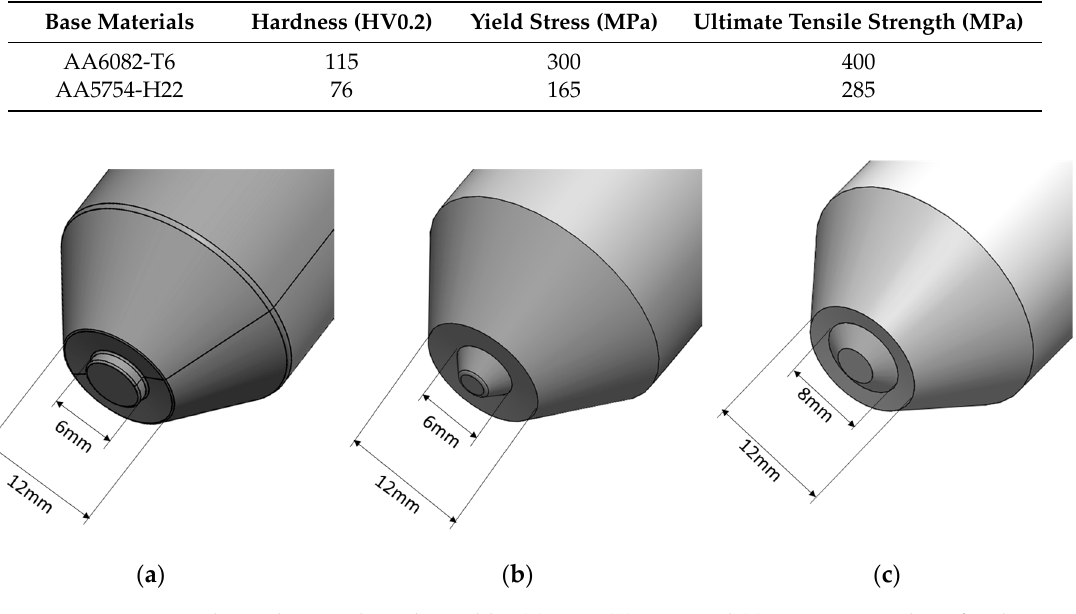
Figure 1. FSW tools used to produce the welds: ( a ) CL6, ( b ) CN6 and ( c ) CN8. CN and CL for the conical and cylindrical pin geometry. Table 2. FSW parameters used to produce the welds.